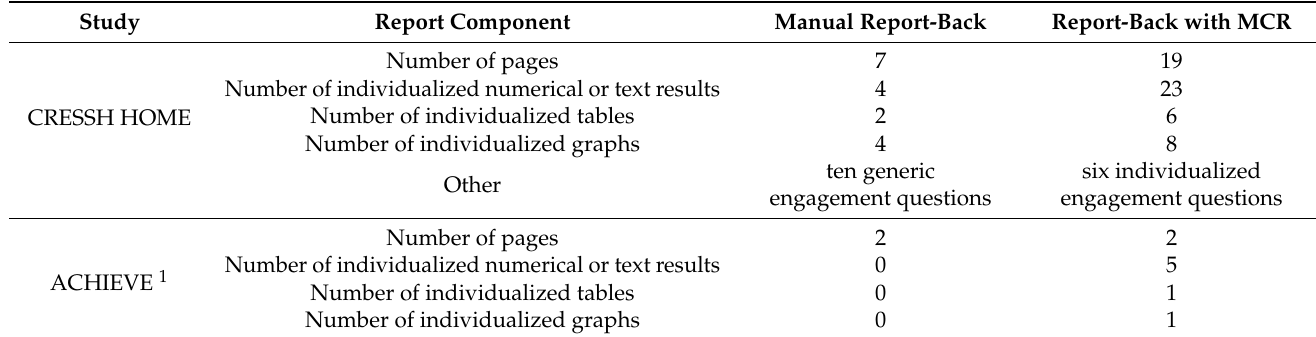
Table 2. Characteristics of reports created manually and using